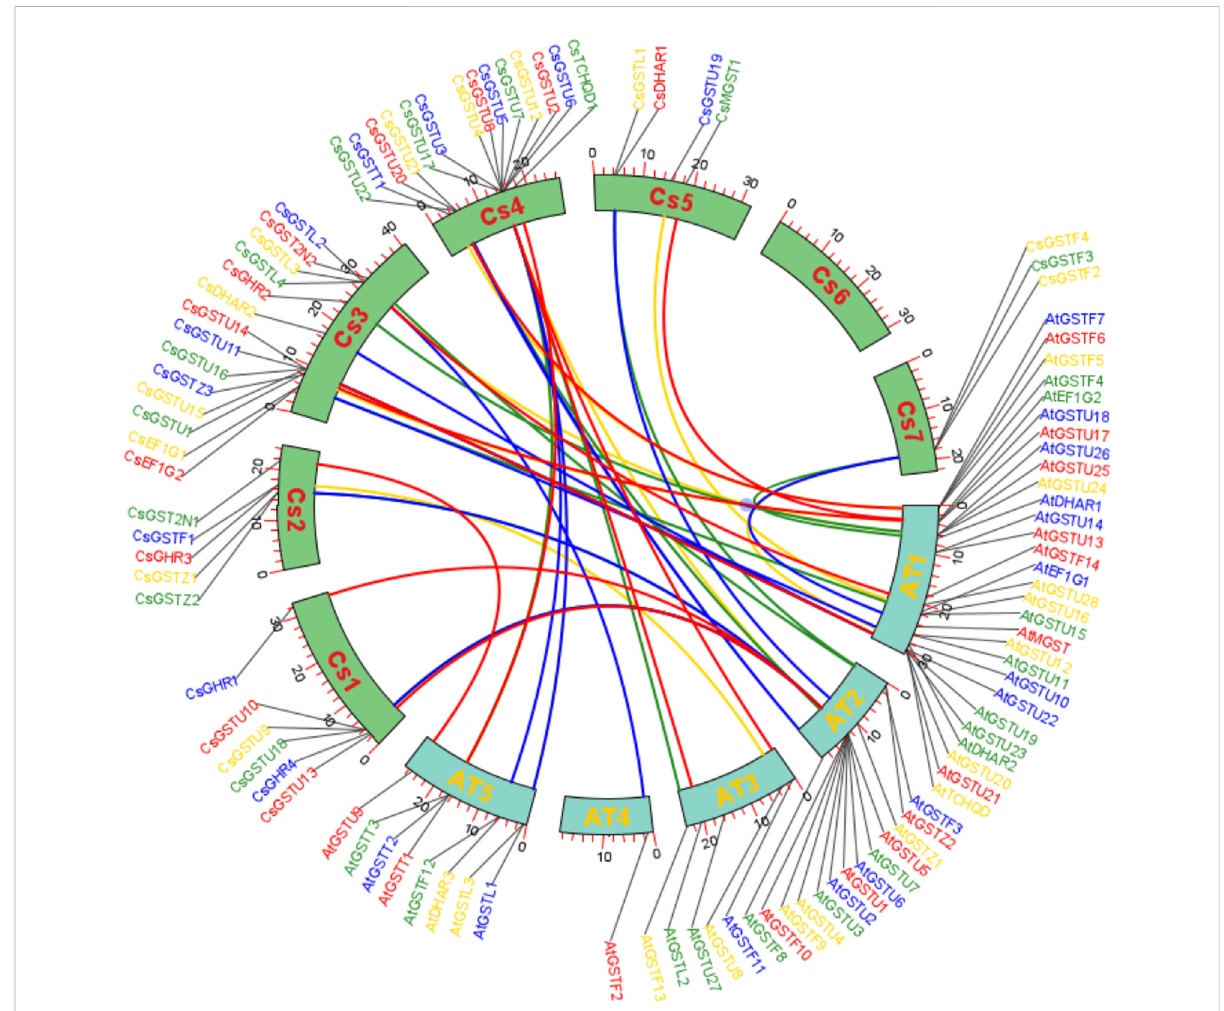
FIGURE 2 SyntenicregionanalysisofGSTgenesbetweencucumberand A.thaliana .CollinearcorrelationsofGSTgenehomologsinthesyntenicregionin cucumber and A. thaliana . The different lines represent homologous proteins between cucumber and A.